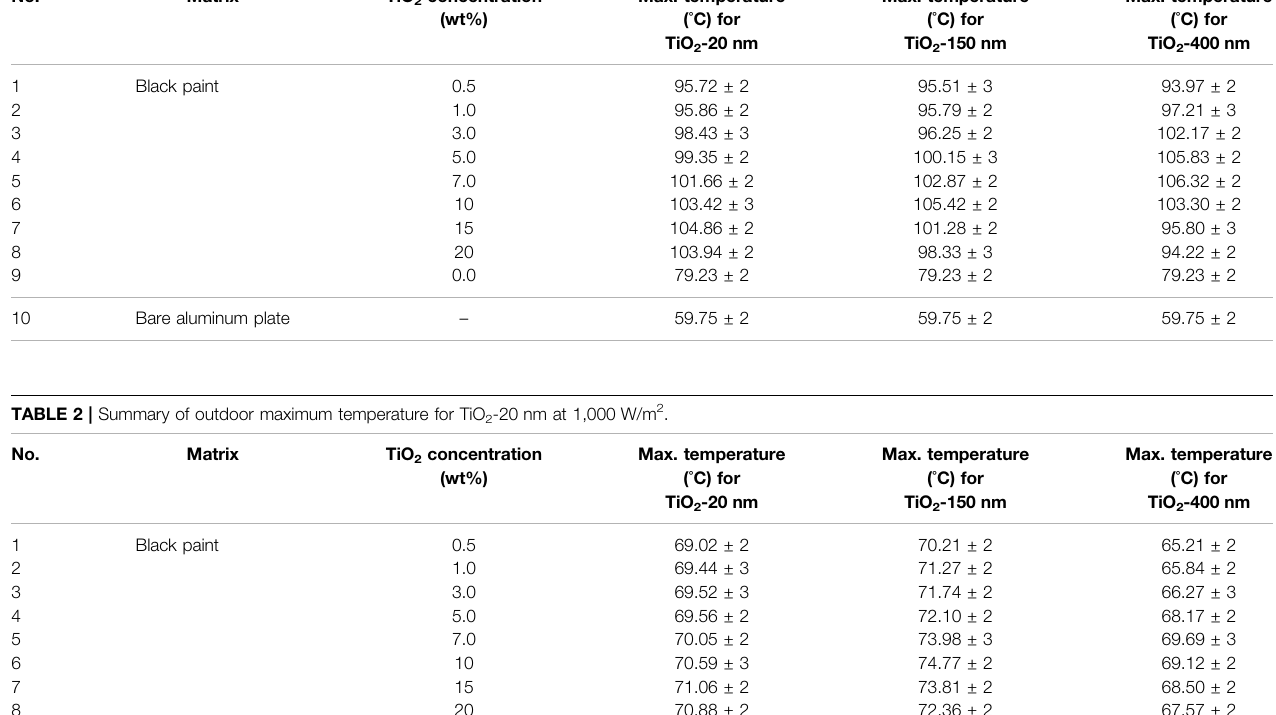
TABLE 1 | Summary of indoor maximum temperature for TiO 2 with varying concentrations and sizes at 1,000 W/m 2 . No.